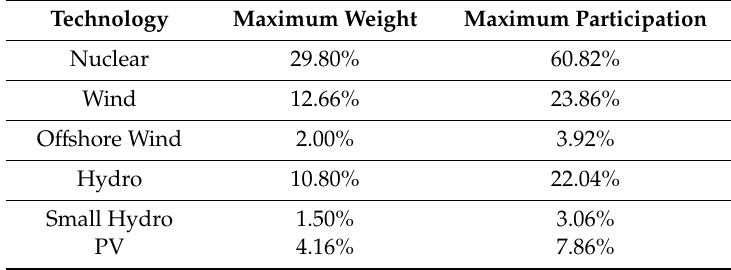
Table 4. Non-pollutant technological and environmental limits. Source: Authors’ own work, based on data collected from DeLlano et al. (2015) [14].